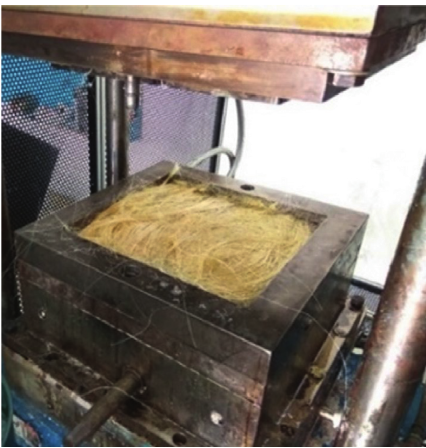
Figure 1: Preparation of samples with a hot compression method.